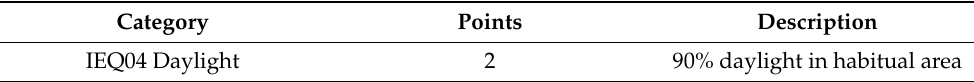
Table 8. Project scorecard Nurses Residence —IEQ category.